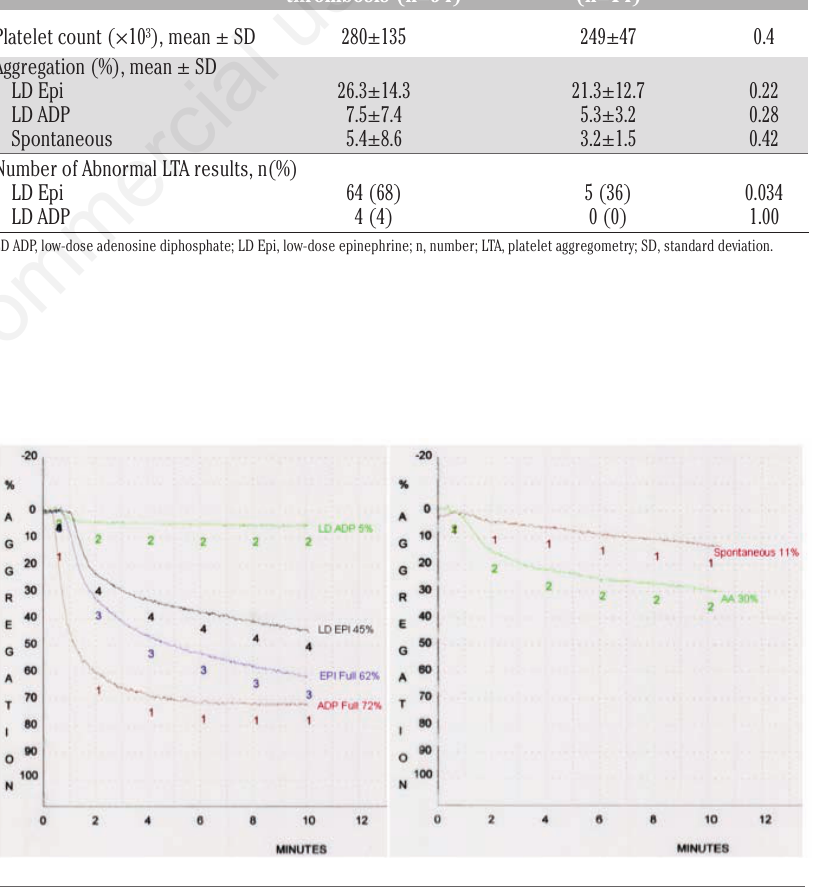
Figure 2. A 69-year-old male presenting with acute deep vein thrombosis of the left lower extremity while on 81 mg of aspirin. Platelet aggregometry remarkable for decreased arachidonic acid aggregation (right graph, curve 2), as well as decreased threshold for aggregation with low-dose epinephrine (left graph, curve